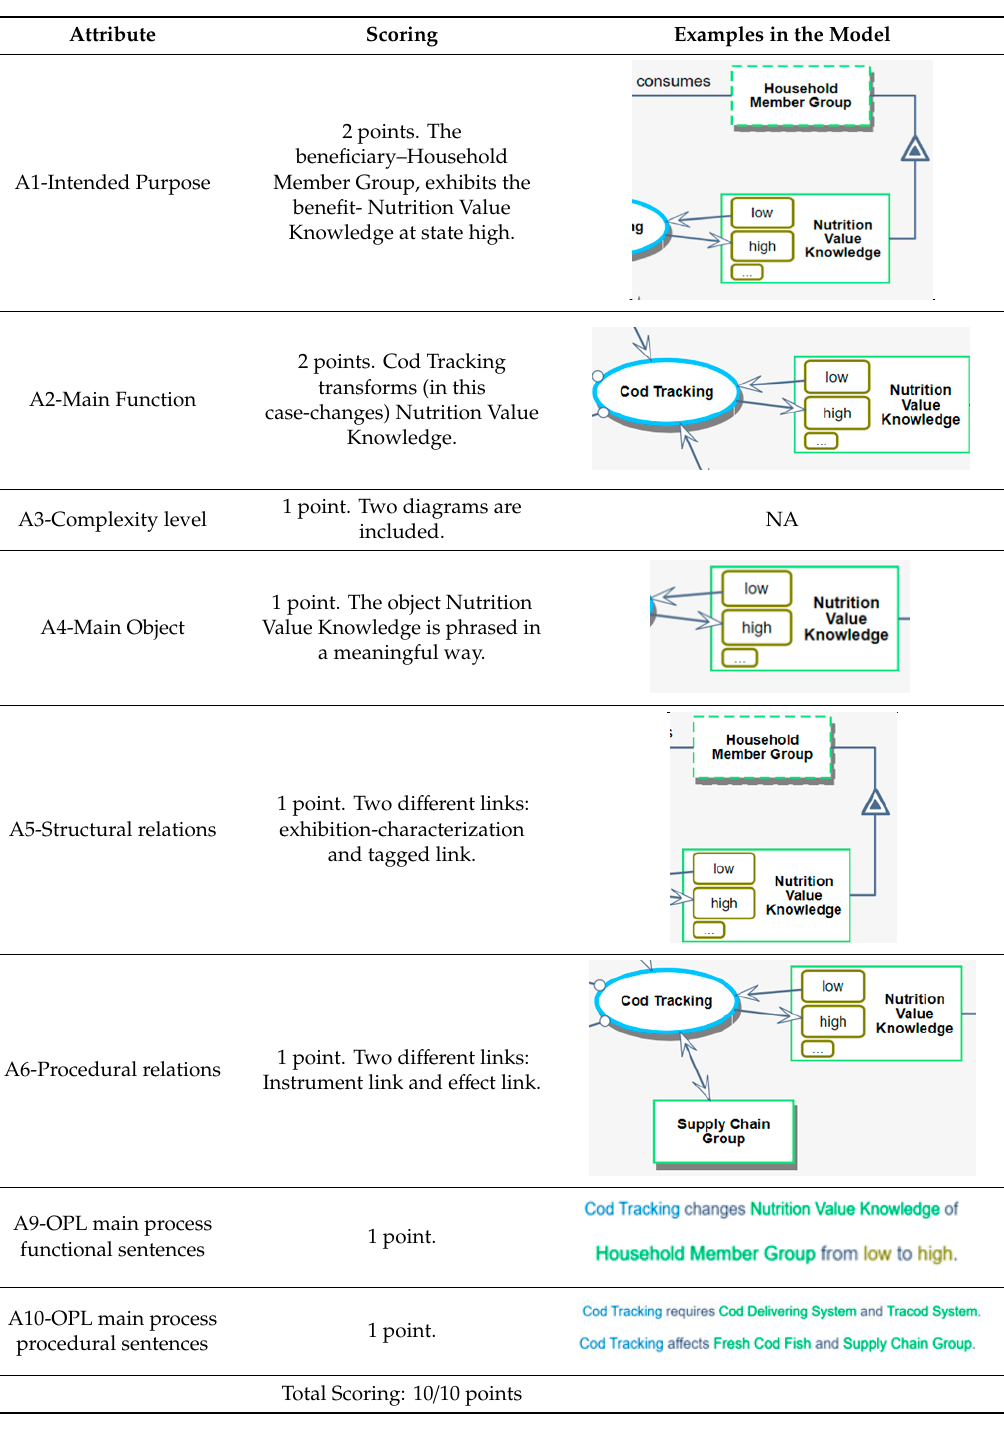
Table 6. STAR* analysis of codfish supply chain model—SD level. Scoring